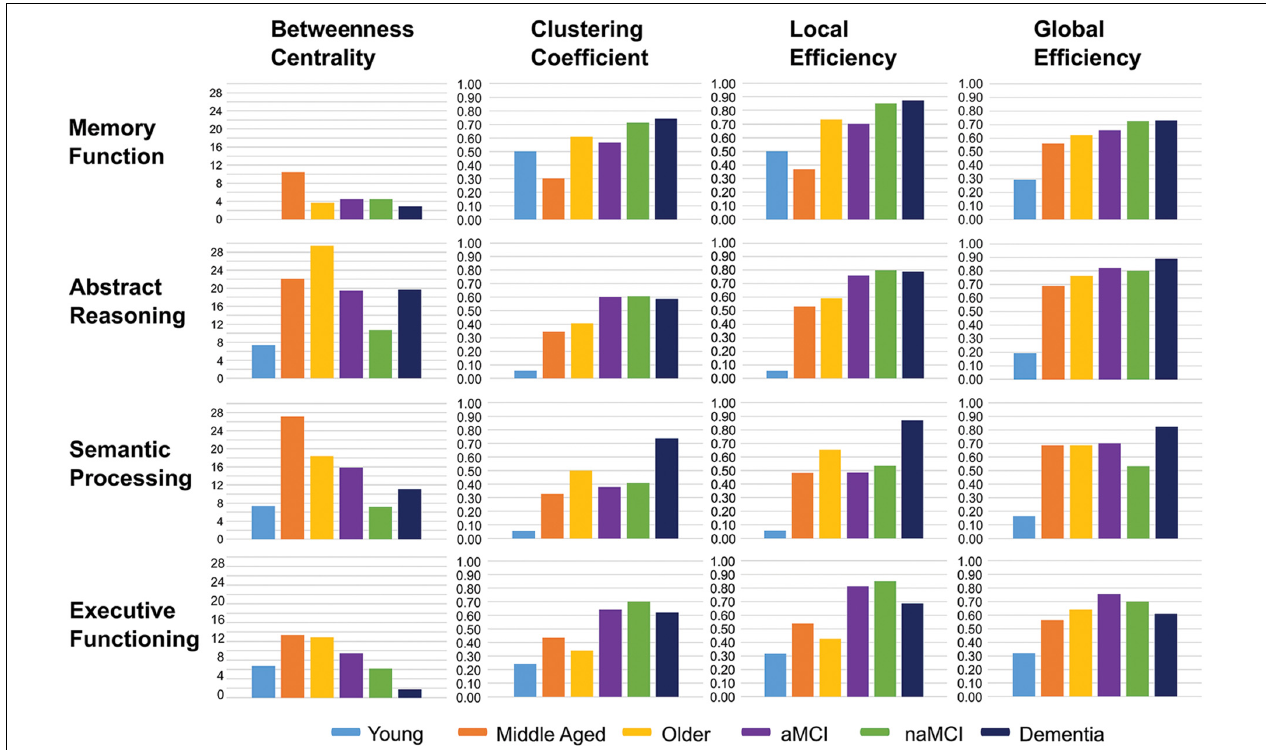
FIGURE 6 | Bar charts showing the average network metrics for each cognitive domain across participant